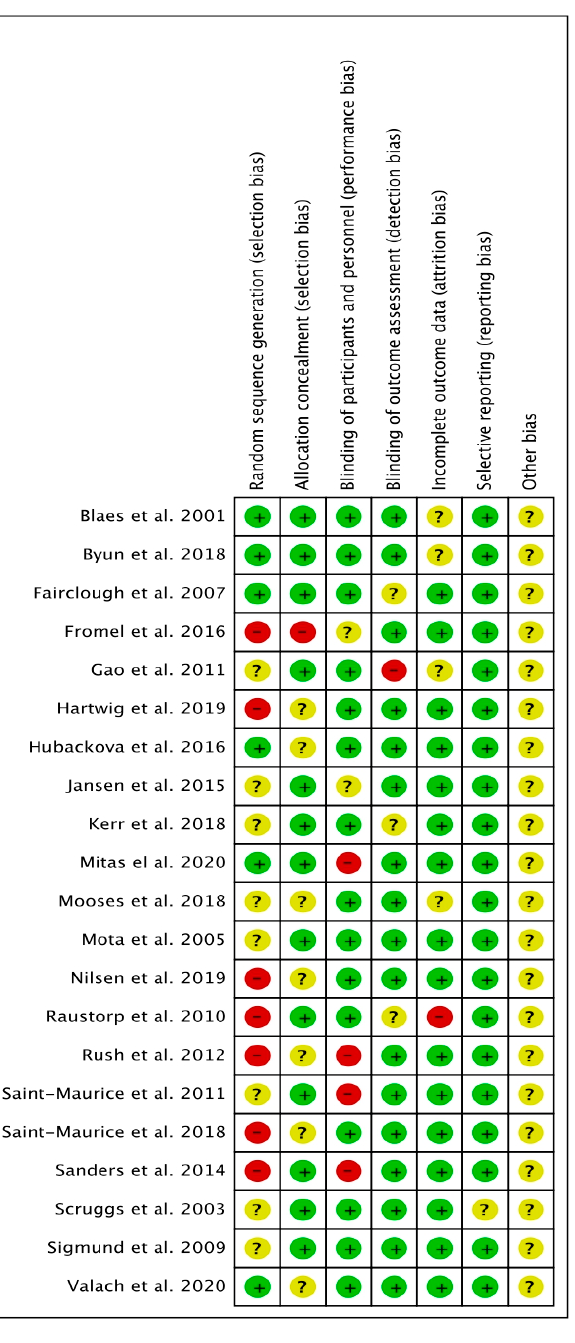
Figure 2. Judgments about each risk of bias item for each included study [42,43,45–63].